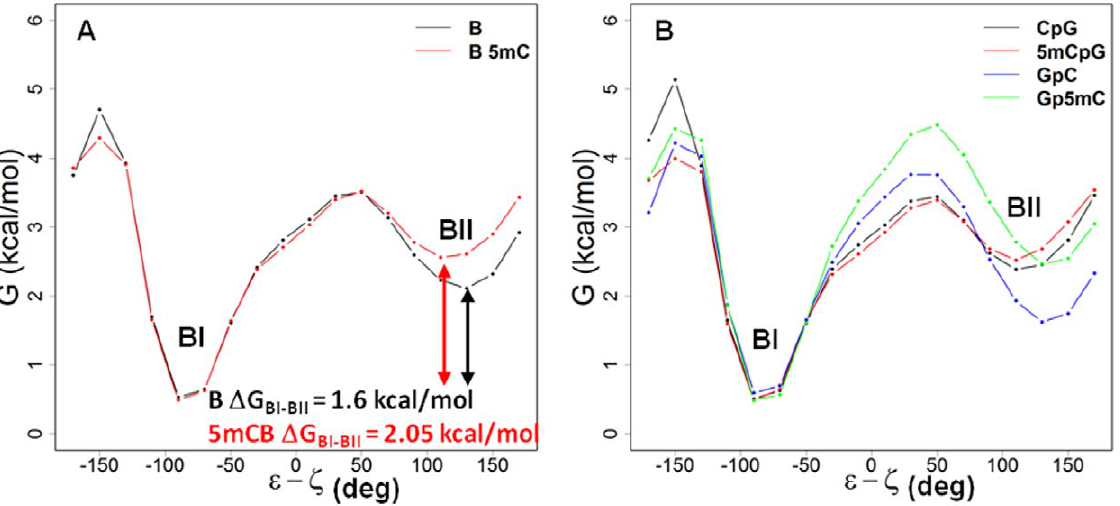
Figure 4. Relative free energy profiles across the e 2 f reaction coordinates in B- and 5mCB-DNA. The plots show the changes in free energy (y-axis) across the e 2 f coordinate range (x-axis) that define the BI and BII sub-states. (A) Overall relative free energy profiles for unmethylated B-DNA ( black ) and methylated 5mCB-DNA ( red ). (B) Relative free energy profiles for unmethylated and methylated CpG and GpC steps. Black , CpG steps of B-DNA; red , 5mCpG steps of 5mCB-DNA; blue , GpC steps of B-DNA; green , Gp5mC steps of 5mCB-DNA.